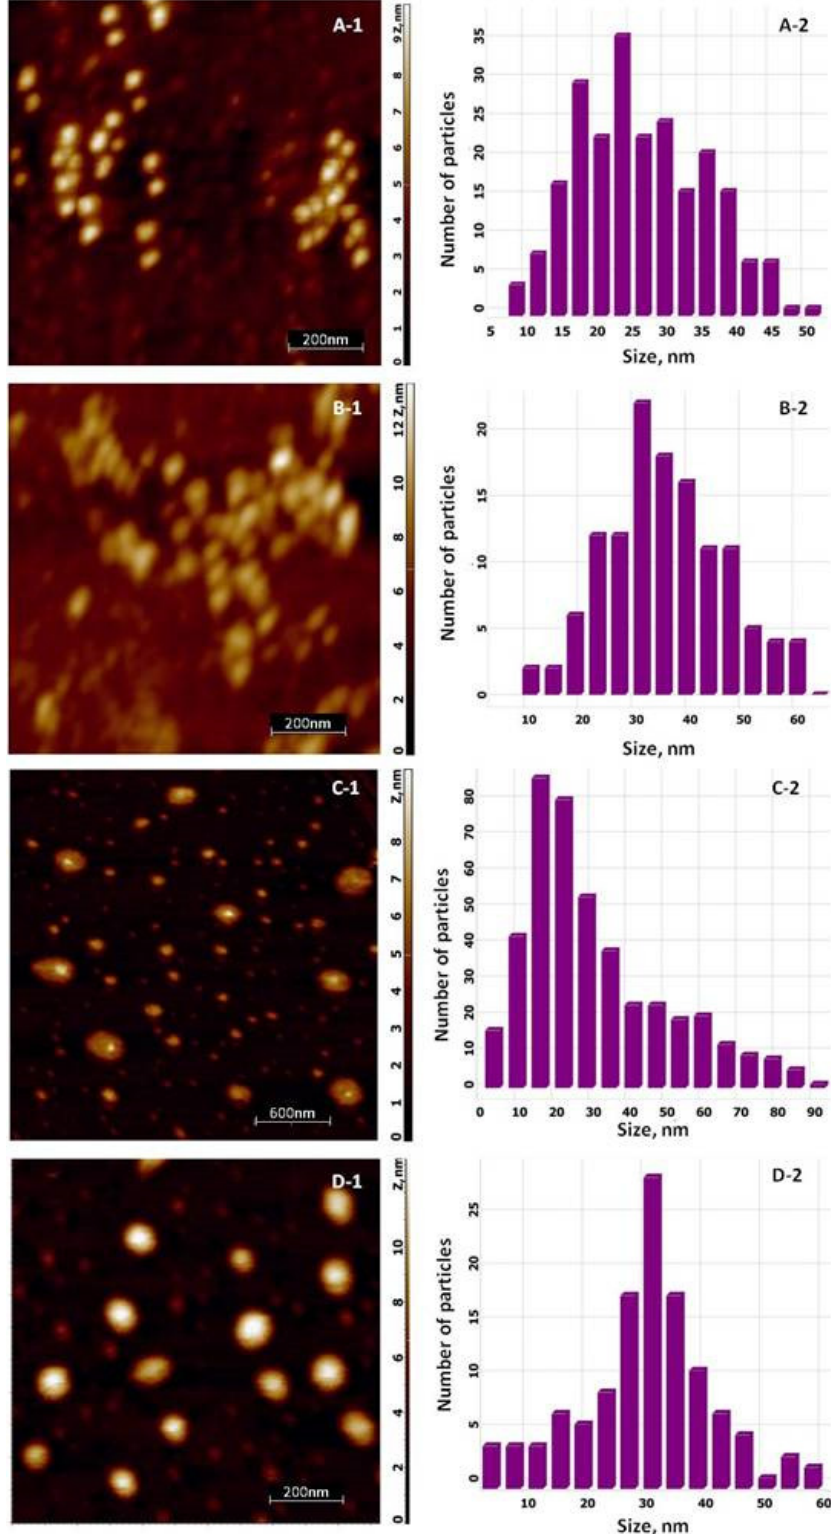
Figure 5. AFM images ( left ) and size distribution of NPs ( right ) for systems: ( A ) pure Tur-nAg/AgCl, ( B ) Tur-nAg/AgCl–CTS, ( C ) Tur-nAg/AgCl–Lip, and ( D )